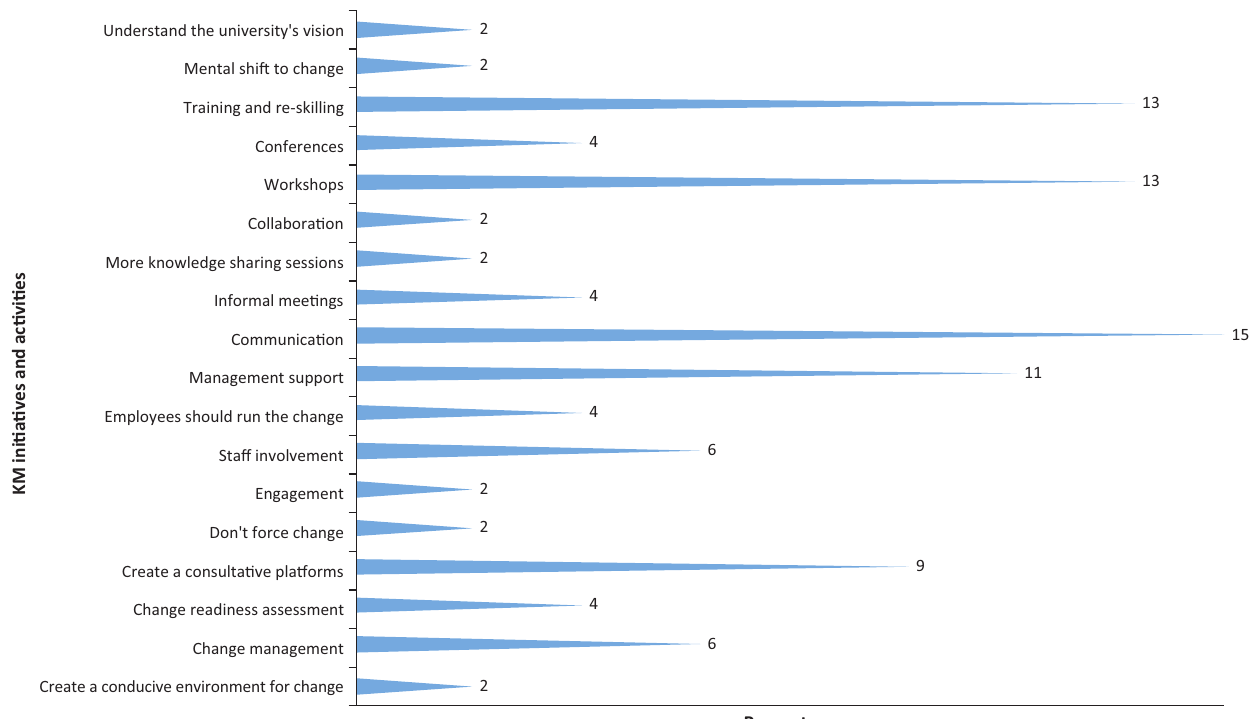
Create a conducive environment for